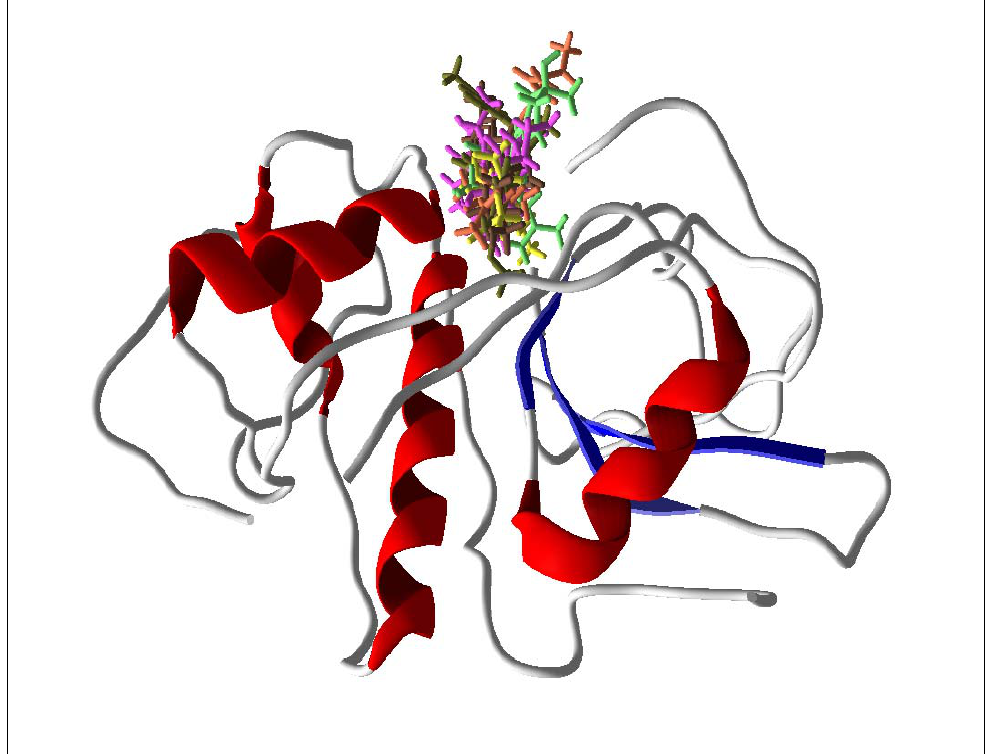
Supplementary Figure 6. Superposition of the five compounds with top poses (shown with different colors) docked to rhodesain, indicating similar binding